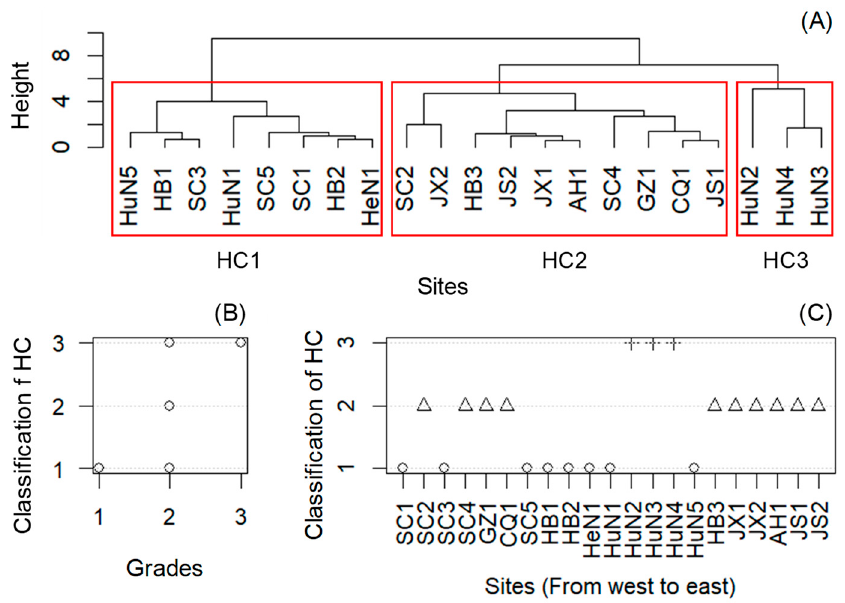
Figure 4. Classification of the YRB sites for 2016 using HC clustering and four monitoring indicators: Hierarchical tree ( A ), grades ( B ), and geographical distribution ( C ). Note: Crosses, triangles and circles in Figure 4-C indicate different HC clusters.